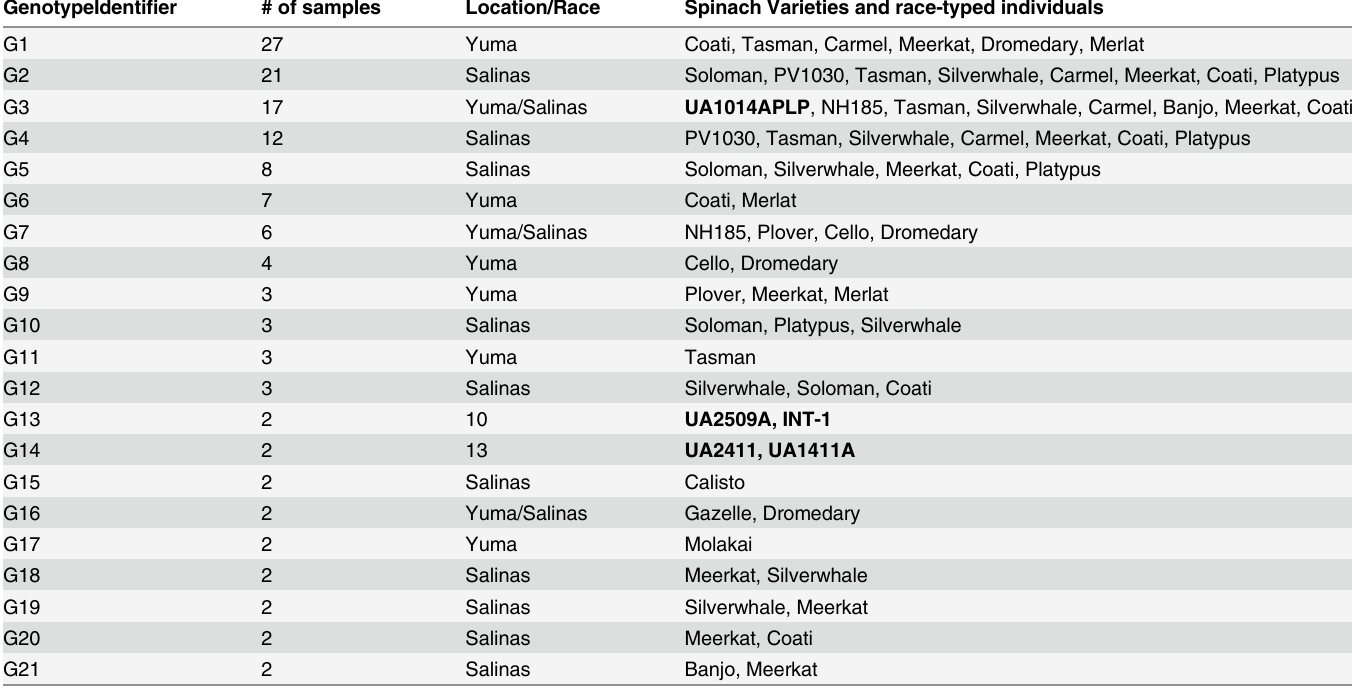
Table 2. Summary data for identical genotypes of downy mildew with race-typed individuals in bold. GenotypeIdenti fi